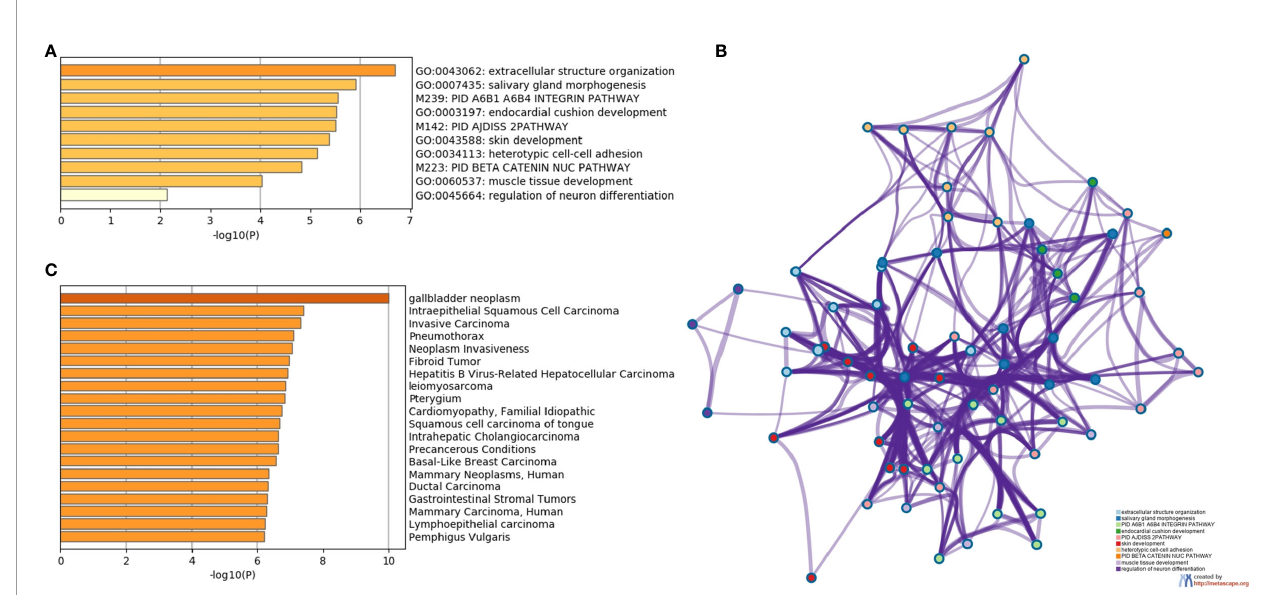
FIGURE 2 | The enrichment analysis of 17 EMT-related genes using Metascape. (A) Heatmap of enriched terms colored by P-values. (B) Protein-protein interaction network. (C) Summary of enrichment analysis in DisGeNET colored by